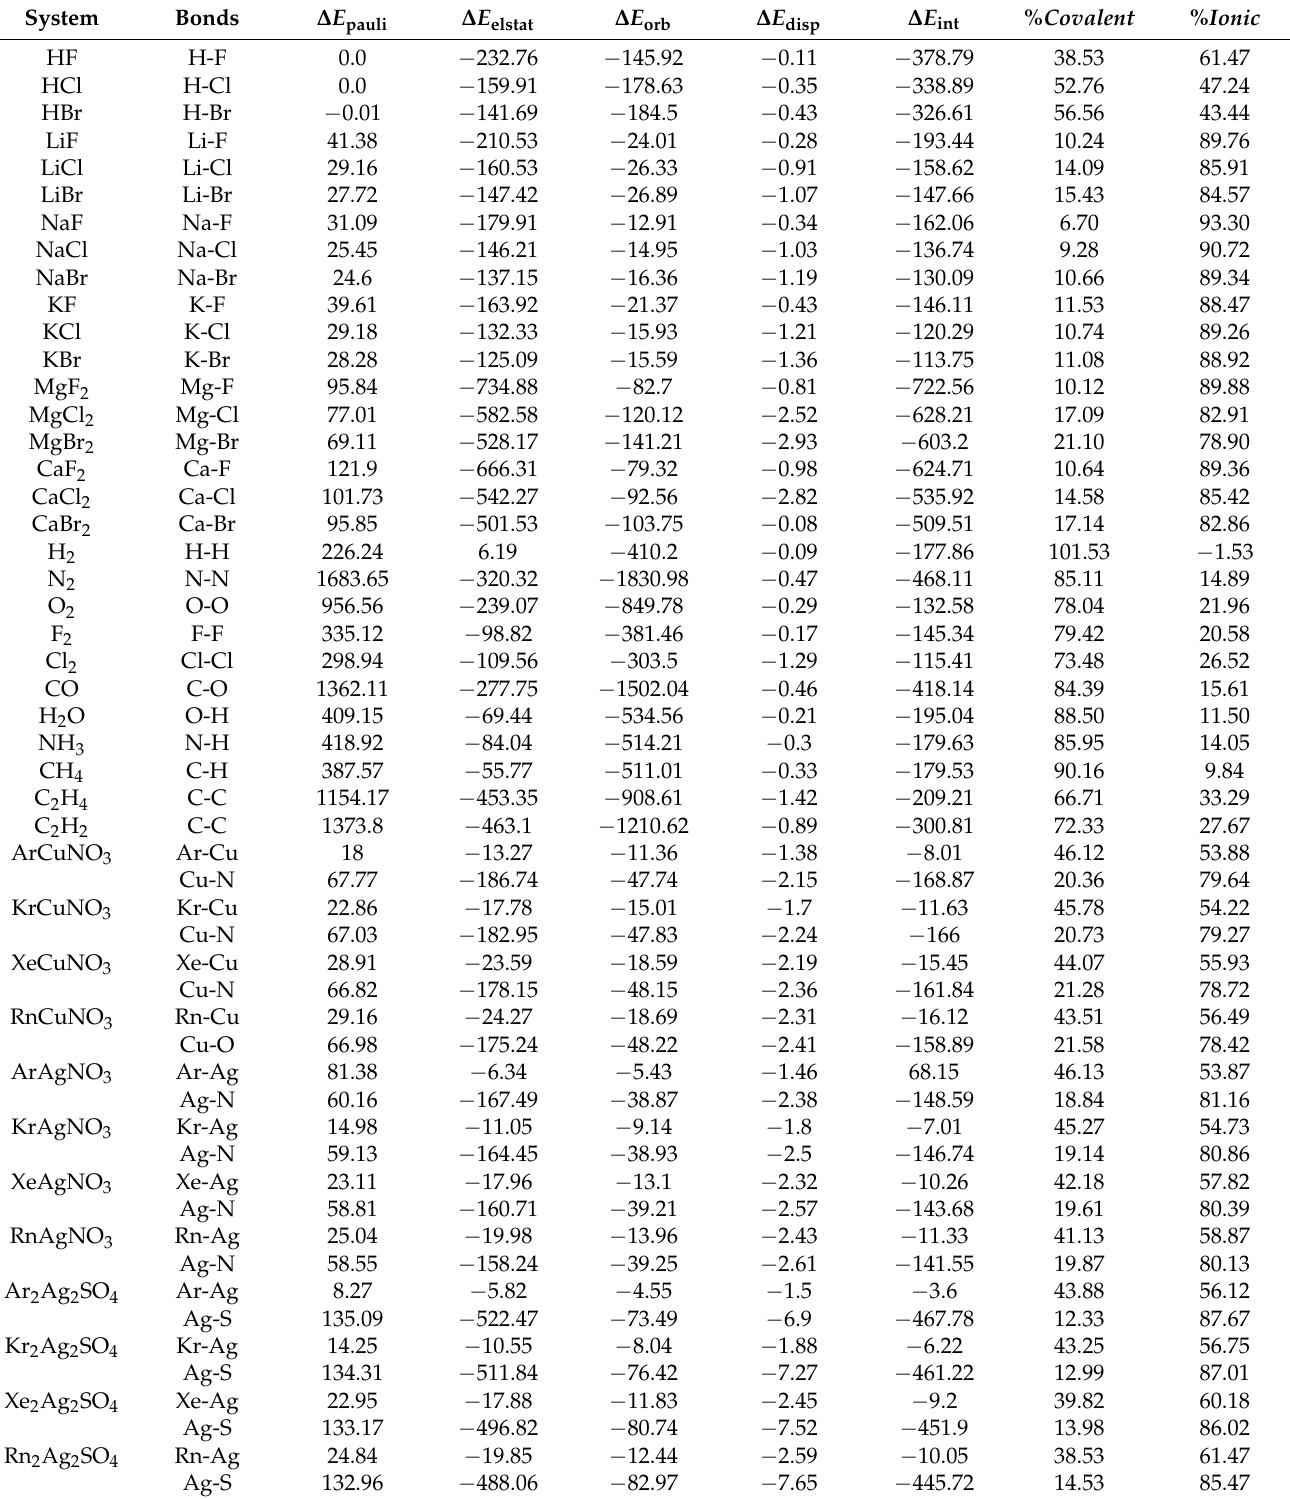
Table 2. The interaction energy components (in kcal mol − 1 ) calculated at the B3LYP-D3(BJ)/TZ2P level obtained from EDA along with the %covalent and ionic characters of the concerned bonds [Reprinted from Ref. [71] with permission from Springer Nature. © 2022, Indian Academy of